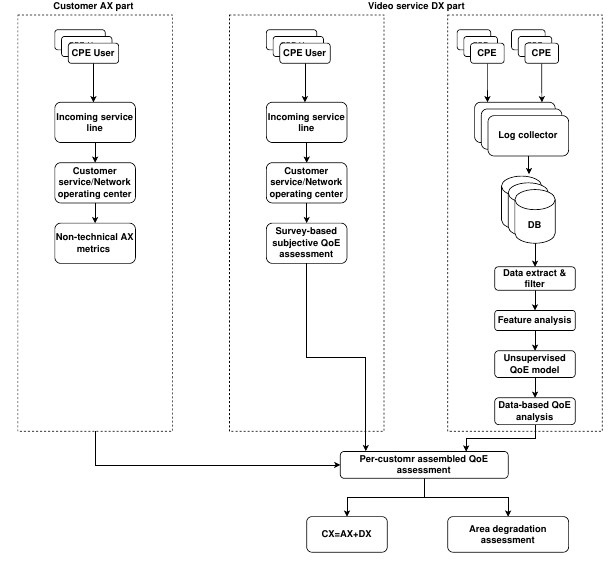
Figure 9. Multi-path QoE